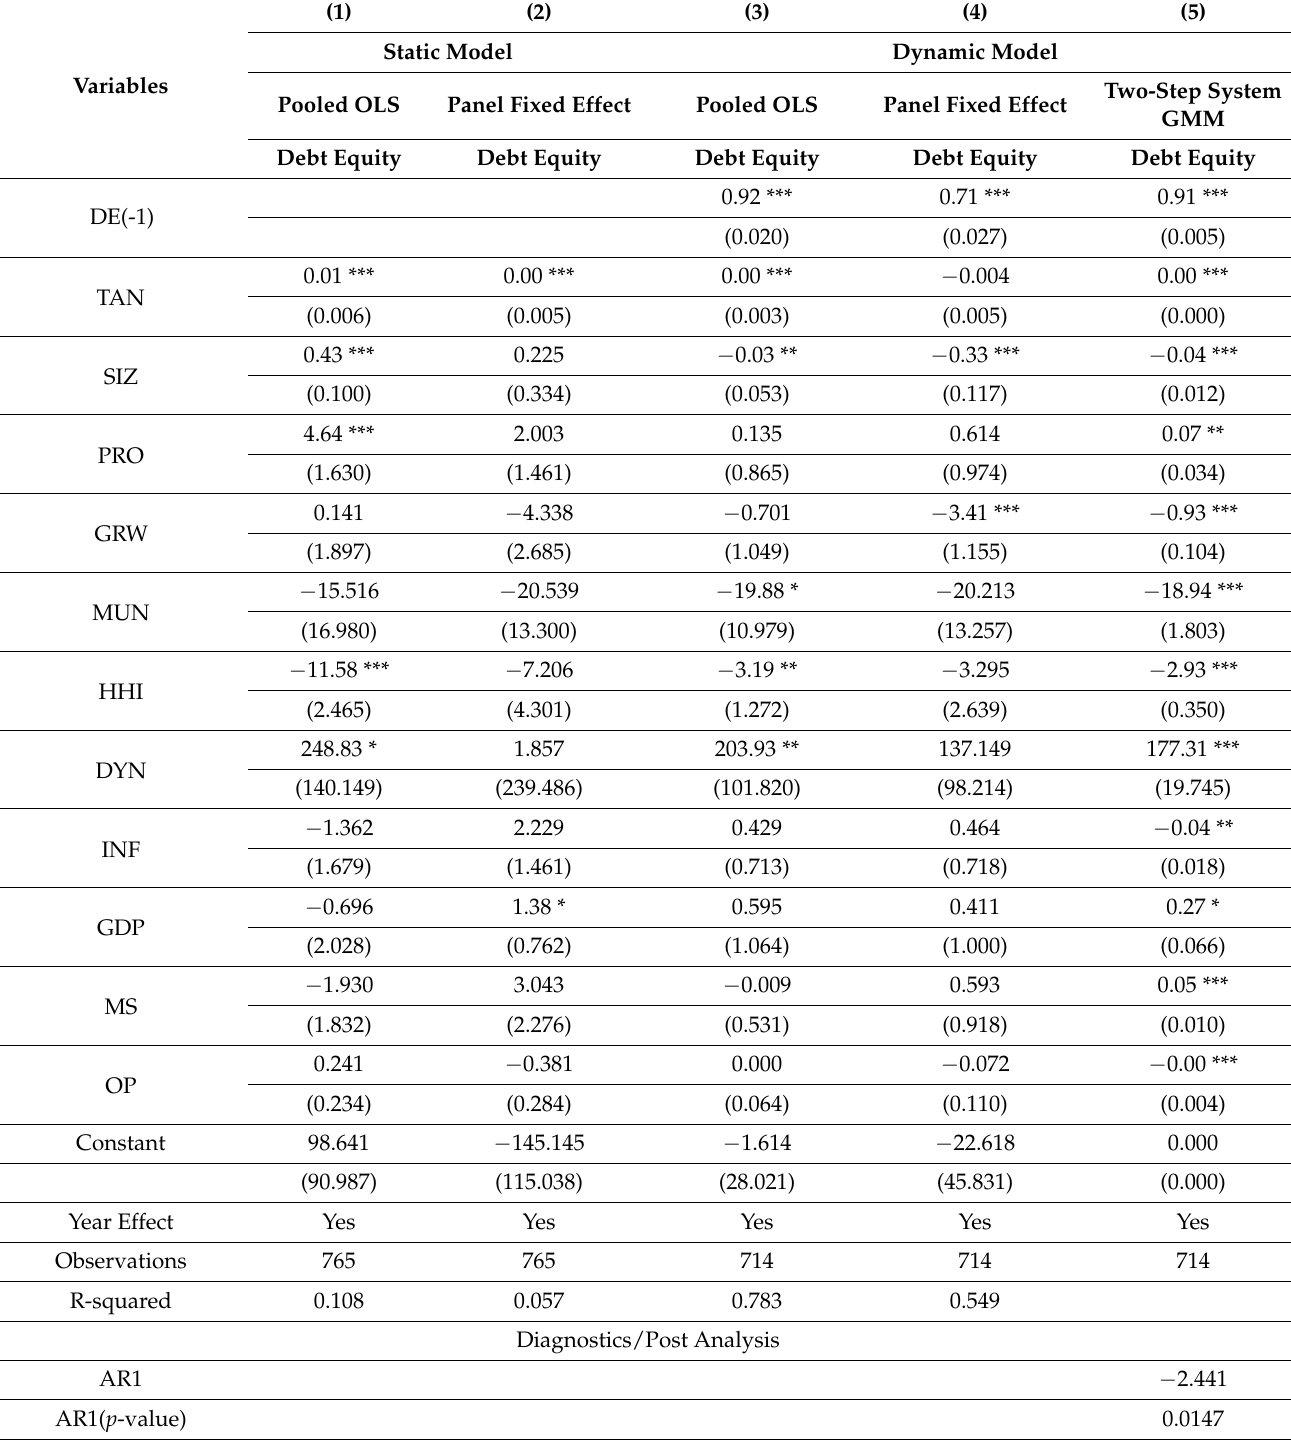
Table 2. Two-step Sys-GMM Results and